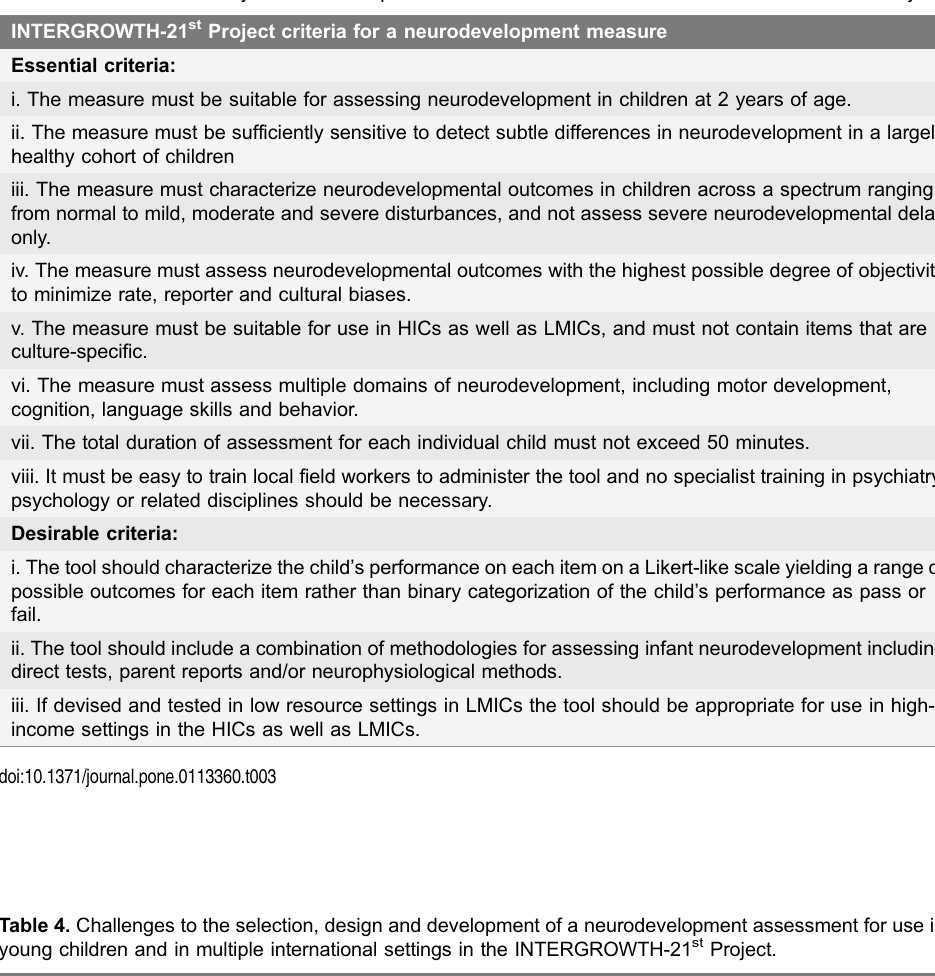
Table 4. Challenges to the selection, design and development of a neurodevelopment assessment for use in young children and in multiple international settings in the INTERGROWTH-21 st